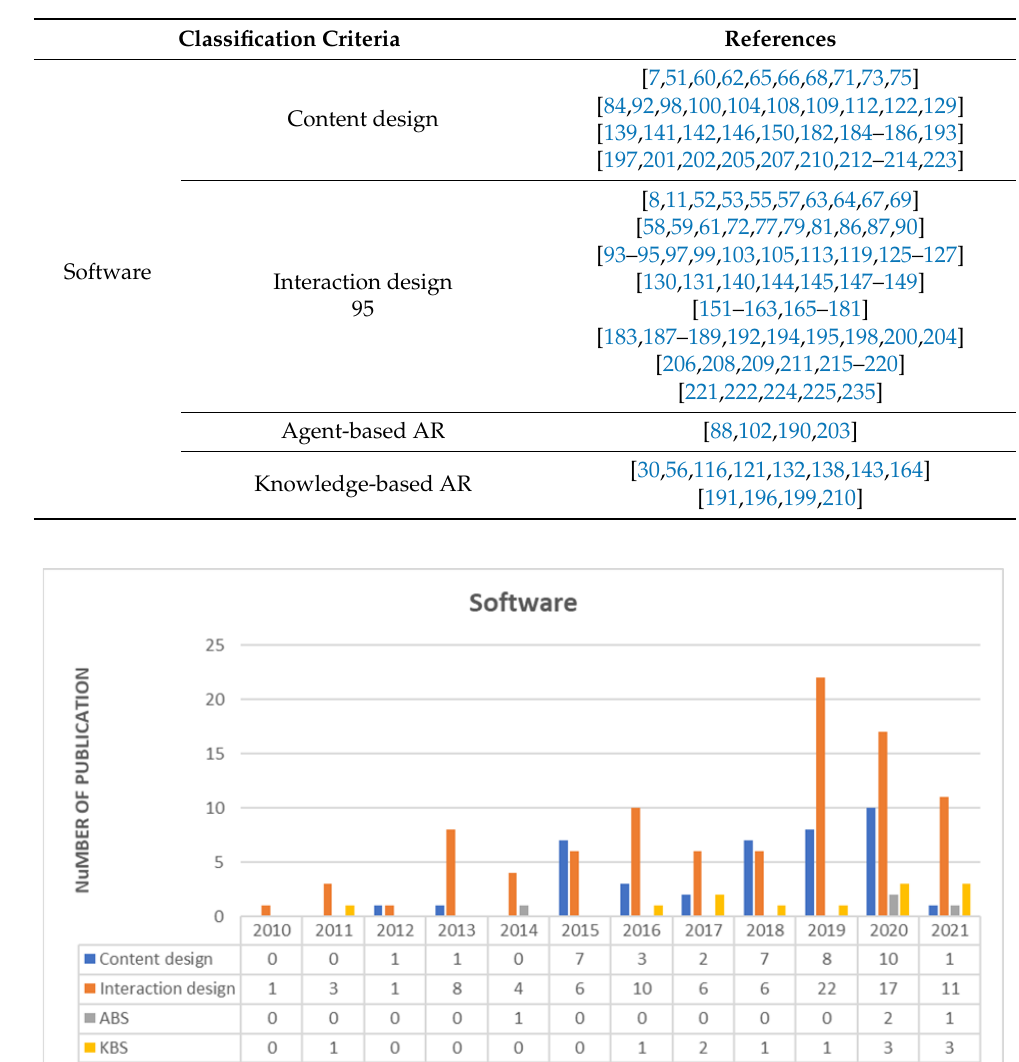
Table 12. Articles on Layer 2 Implementation-sublayer Software from 2010–2021. Classification Criteria